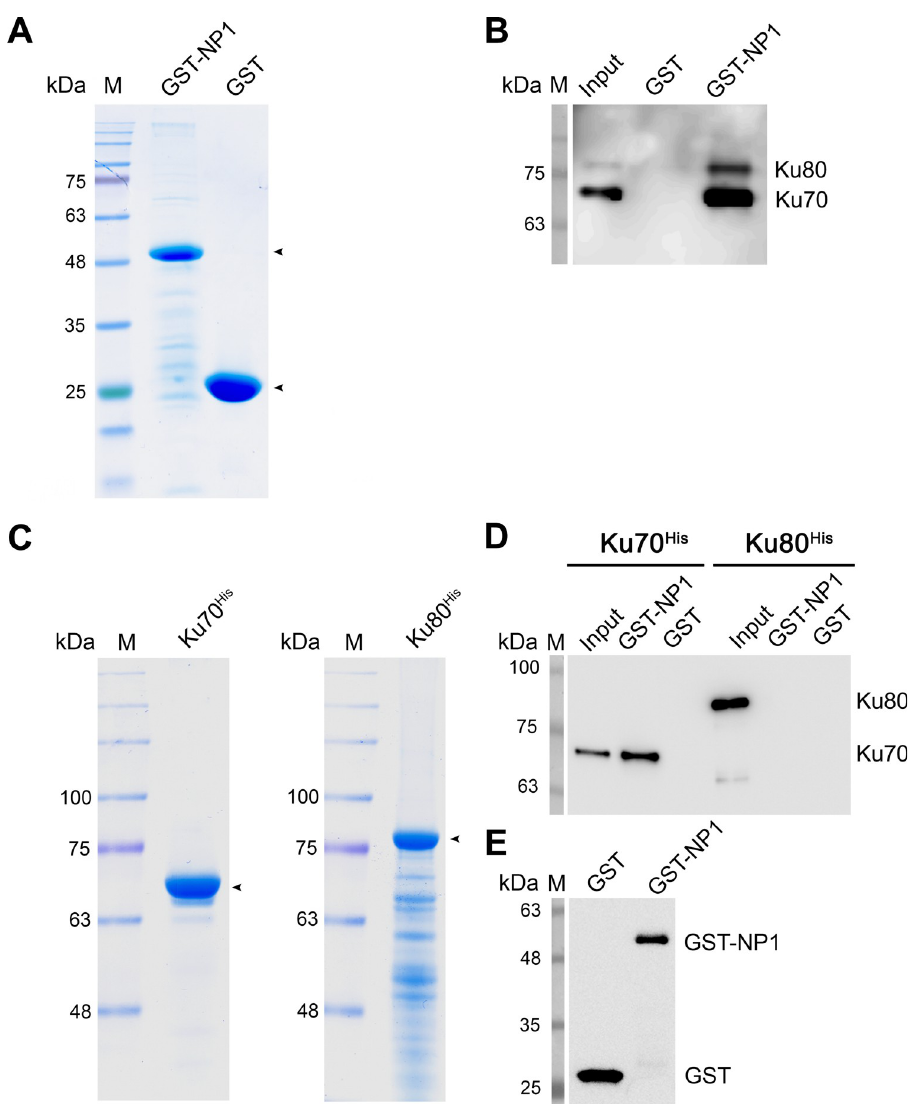
Fig 3. NP1 directly interacts with Ku70 but not Ku80. (A) Purification of HBoV1 GST-NP1 and GST proteins. HBoV1 GST-NP1 and GST protein were purified as described in Materials and Methods. The eluted GST-NP1 and GST proteins from peaked fractions were separated on an SDS-(4–20%)PAGE gel and stained with Coomassie brilliant blue. (B) In vitro pull-down assay of Ku70/80 heterodimer. 4 μ g of purified GST-NP1 was used as bait to pull down 4 μ g of the prey protein, purified His-tagged Ku70/80 heterodimer (#CT018-H07B, SinoBiological, Wayne, PA), using Glutathione agarose. 4 μ g of GST served as a negative control. Proteins pulled down by the Glutathione agarose were separated on SDS-PAGE gel and blotted with anti-His ( B ). ~0.4 μ g of Ku heterodimer was used as an input. (C-E) Purification and in vitro pull-down of Ku70 His and Ku80 His . Ku70 His and Ku80 His proteins were purified and analyzed on an SDS-(10%)PAGE gel (C). 4 μ g of purified GST-NP1 and negative control GST protein were used as bait to pull down 4 μ g of the prey protein, purified Ku70 His and Ku80 His , respectively, using Glutathione agarose. ~0.4 μ g of the bait and prey proteins were loaded as inputs. Purified proteins were denoted by arrowheads and the pulldown proteins were analyzed by Western blotting using anti-His for Ku70 His and Ku80 His (D) or using ant-GST for GST-NP1 and GST pulled down by glutathione agarose (as a control) (E).